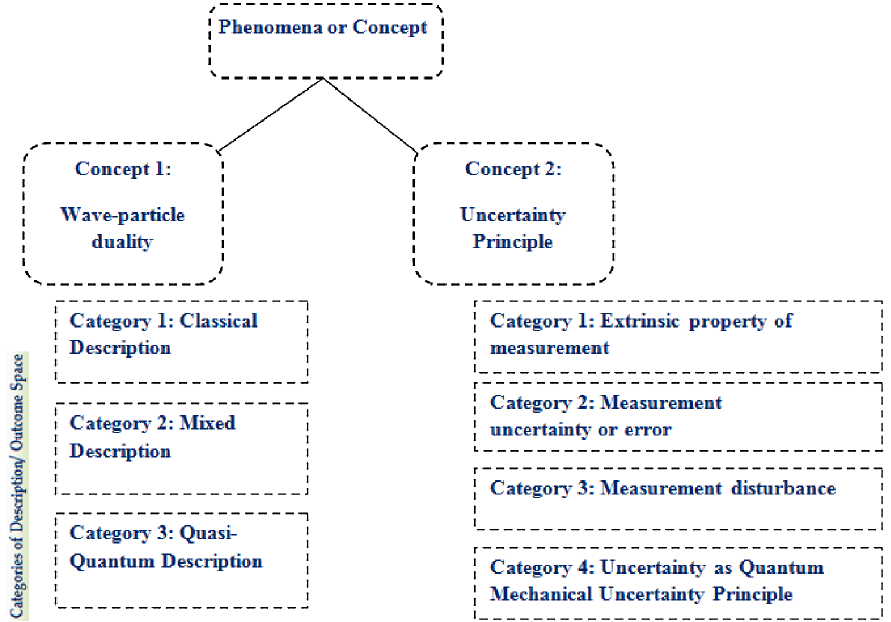
FIG. 1 (color online). The graphical layout of the two concepts and categories of